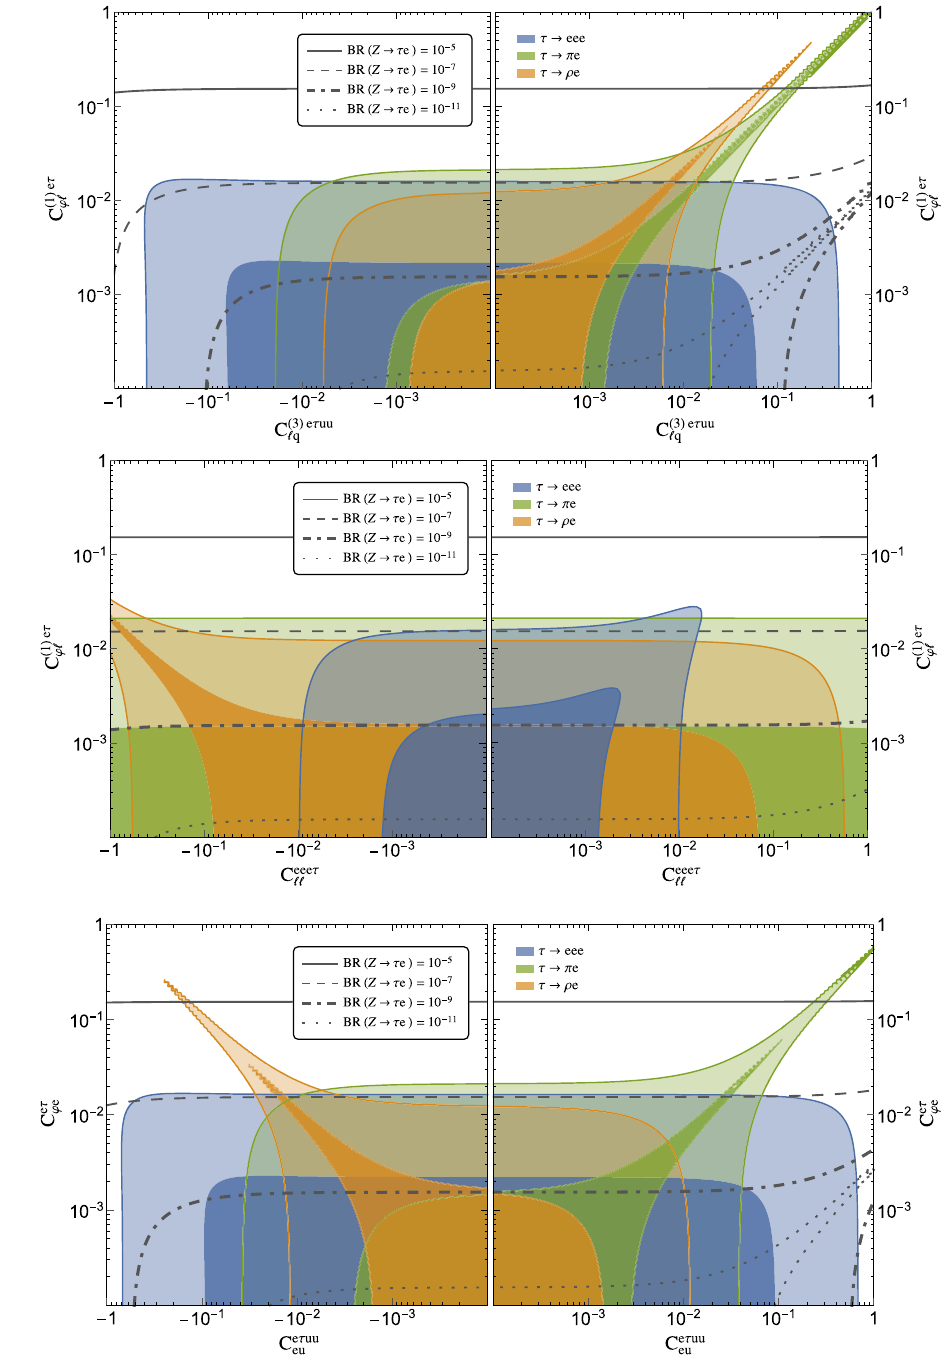
even 10 − 7 –10 − 8 if LFV effects are induced by TeV-scale new